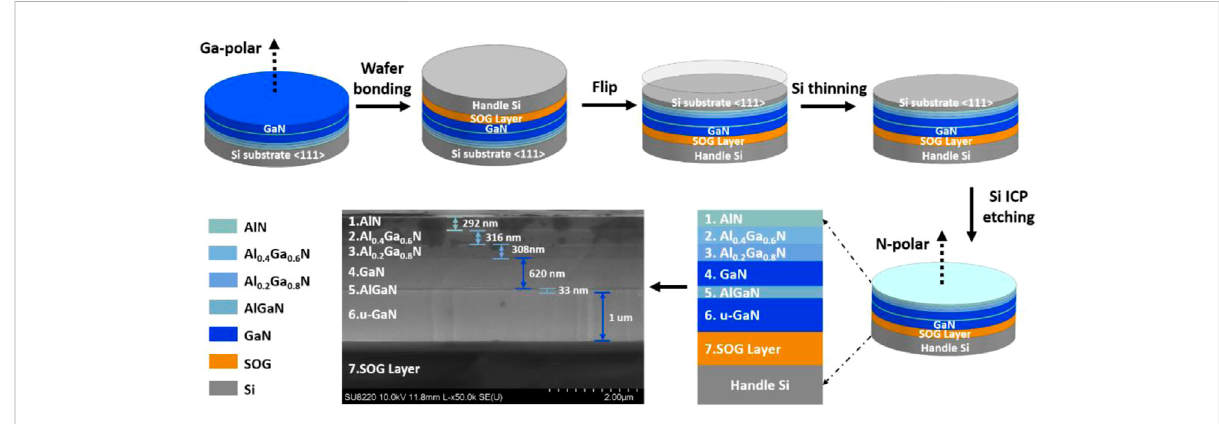
FIGURE 1 TheschematicofobtainingN-polarAl(Ga)N fi lmsprocessthroughwaferbondingandsubstrateremovalandthecross-sectionalSEMpictureof the bonded epi-layers.